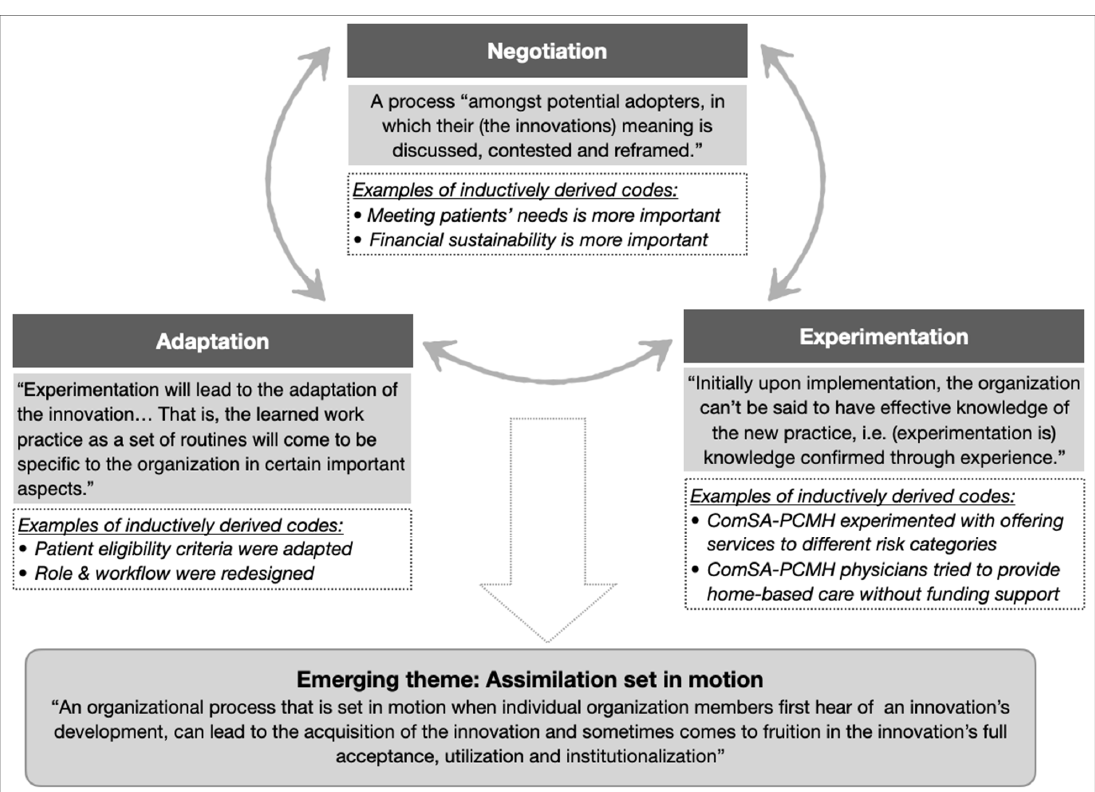
Figure 3. The theme of assimilation emerged from the cyclical relationships between three categories (negotiation, experimentation, and adaptation). Categories were developed from clusters of related codes (examples in italics). Supporting theory (in shaded boxes, adapted from [25,50]) was used to identify categories and emerging themes.